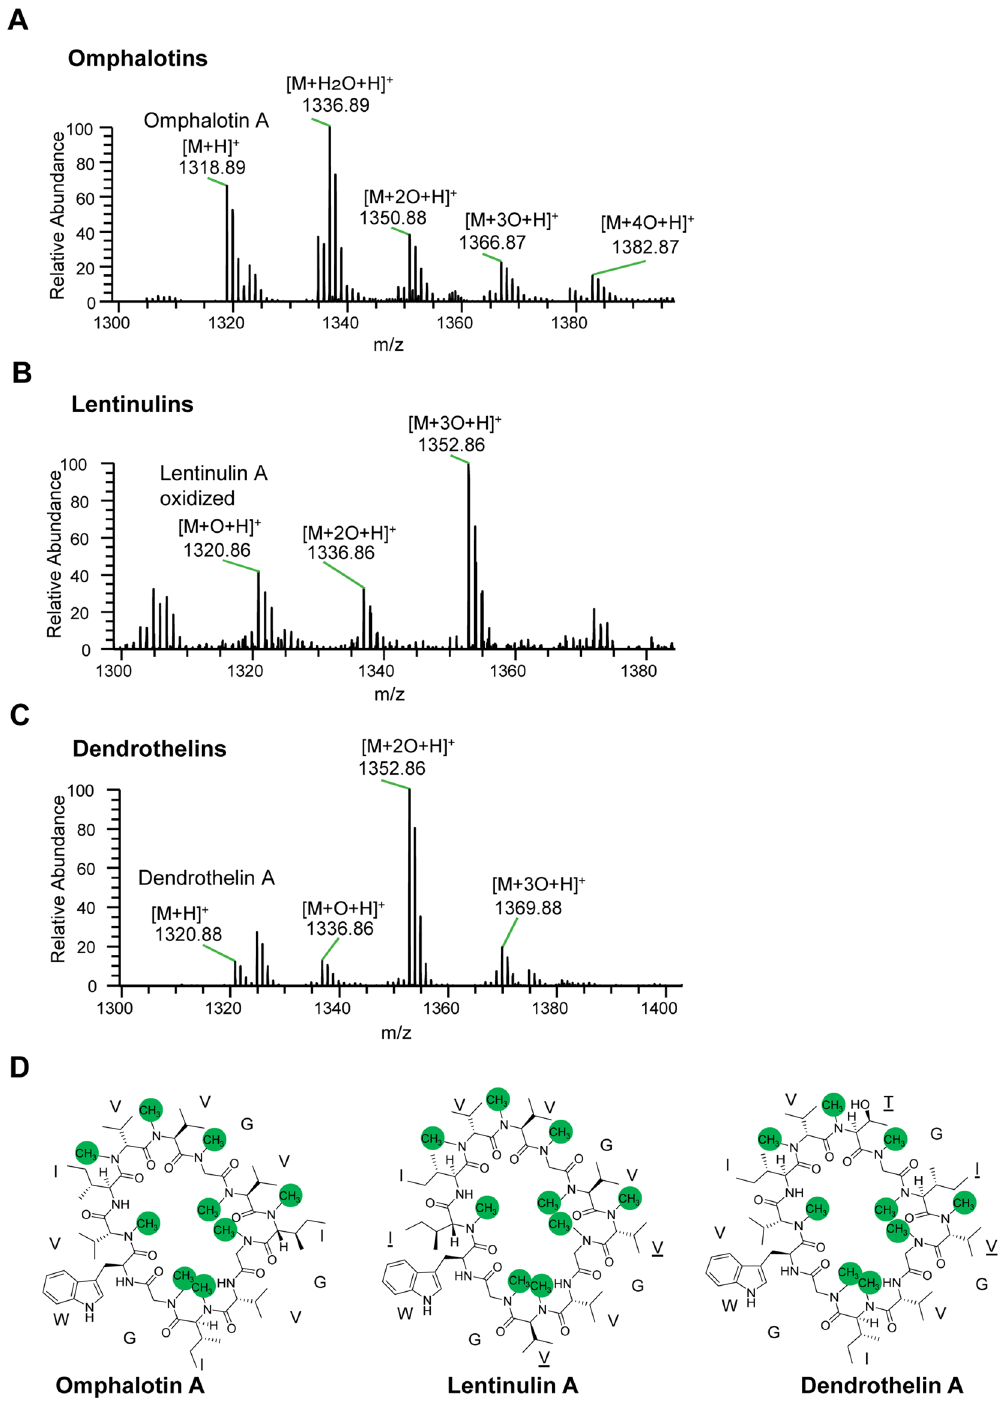
Figure 4. LC–MS analysis of backbone N-methylated peptides extracted from mushrooms O. olearius , L. edodes and D. bispora . ( A – C ) Ion chromatograms depicting some of the peptides species produced by 28 days liquid cultures of the respective fungi. In case of O. olearius ( A ) and D. bispora ( B ), both backbone-N- methylated macrocyclic peptides (M + H + ) and additionally oxidized macrocyclic peptides (M + nO + H) + thereof were observed in the culture supernatant. In case of the L. edodes liquid culture ( C ) , oxidized cyclic peptides were detected in the fungal mycelium. (M + 2HO + H) + represents the linear form of the macrocyclic peptide. ( D ) Chemical structures of omphalotin A, lentinulin A and dendrothelin A. Residues different from omphalotin A are underlined. Backbone N-methylation is indicated by green